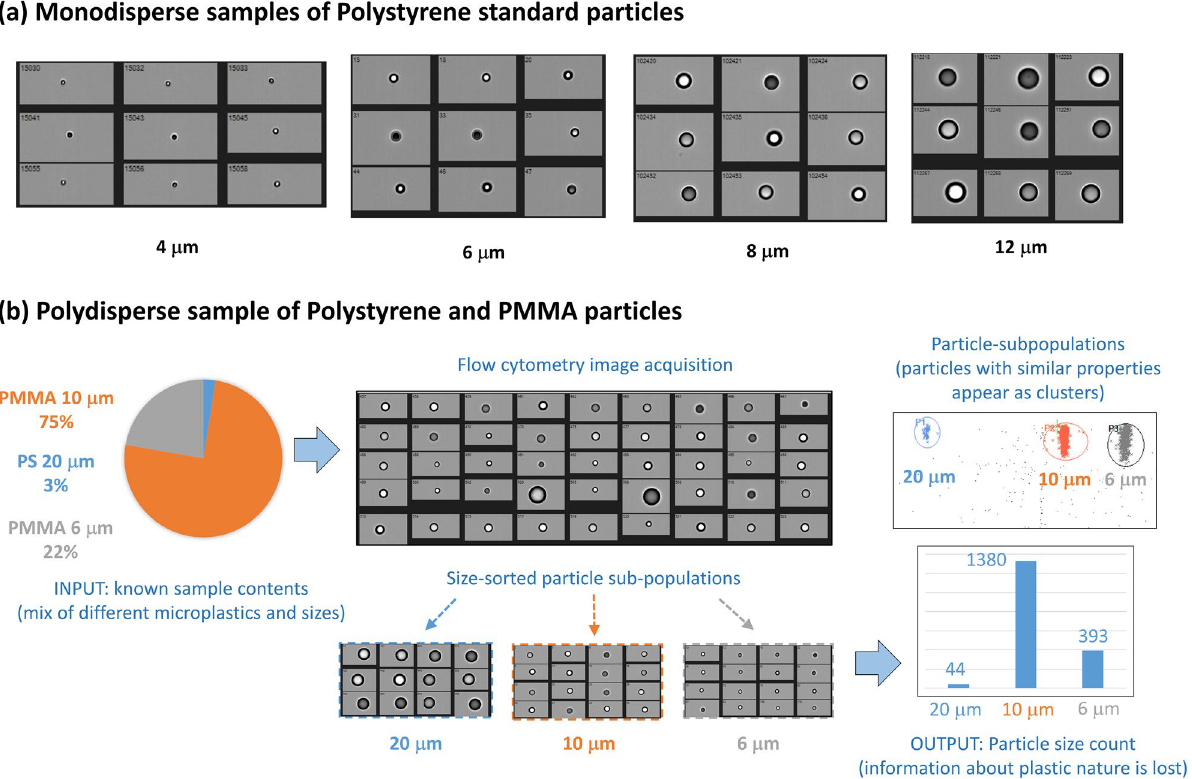
Figure 3. Flow cytometry results. Model solutions of ultra-pure water and standard microplastic particles of different types and sizes are analyzed using the flow cytometer. ( a ) Obtained images for individual particles in different monodisperse samples of standard PS spheres of different sizes (4 µm, 6 µm, 8 µm and 12 µm) ( b ) A polydisperse sample of (PMMA 6 µm, PMMA 10 µm, PS 20 µm) is analyzed and images for each particle in the solution is obtained, along with statistics about the counts of particles of different sizes in the